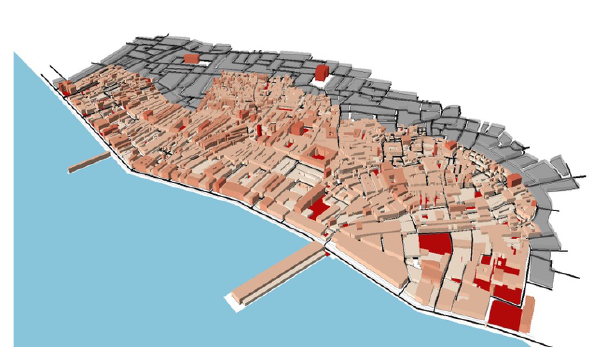
Figure – 8 3D visualization of 1905 Izmir ArcScene